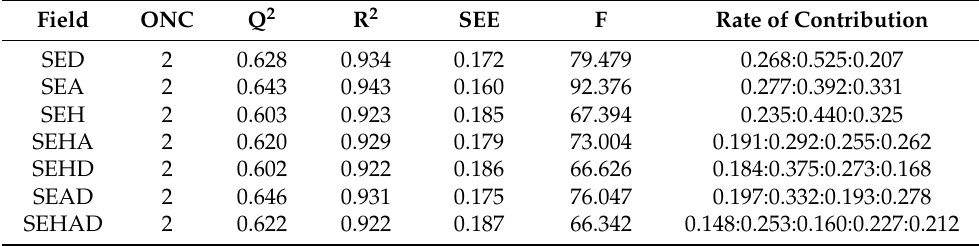
Table 3. Different field combinations in CoMSIA analysis keeping S and E fields in all cases for